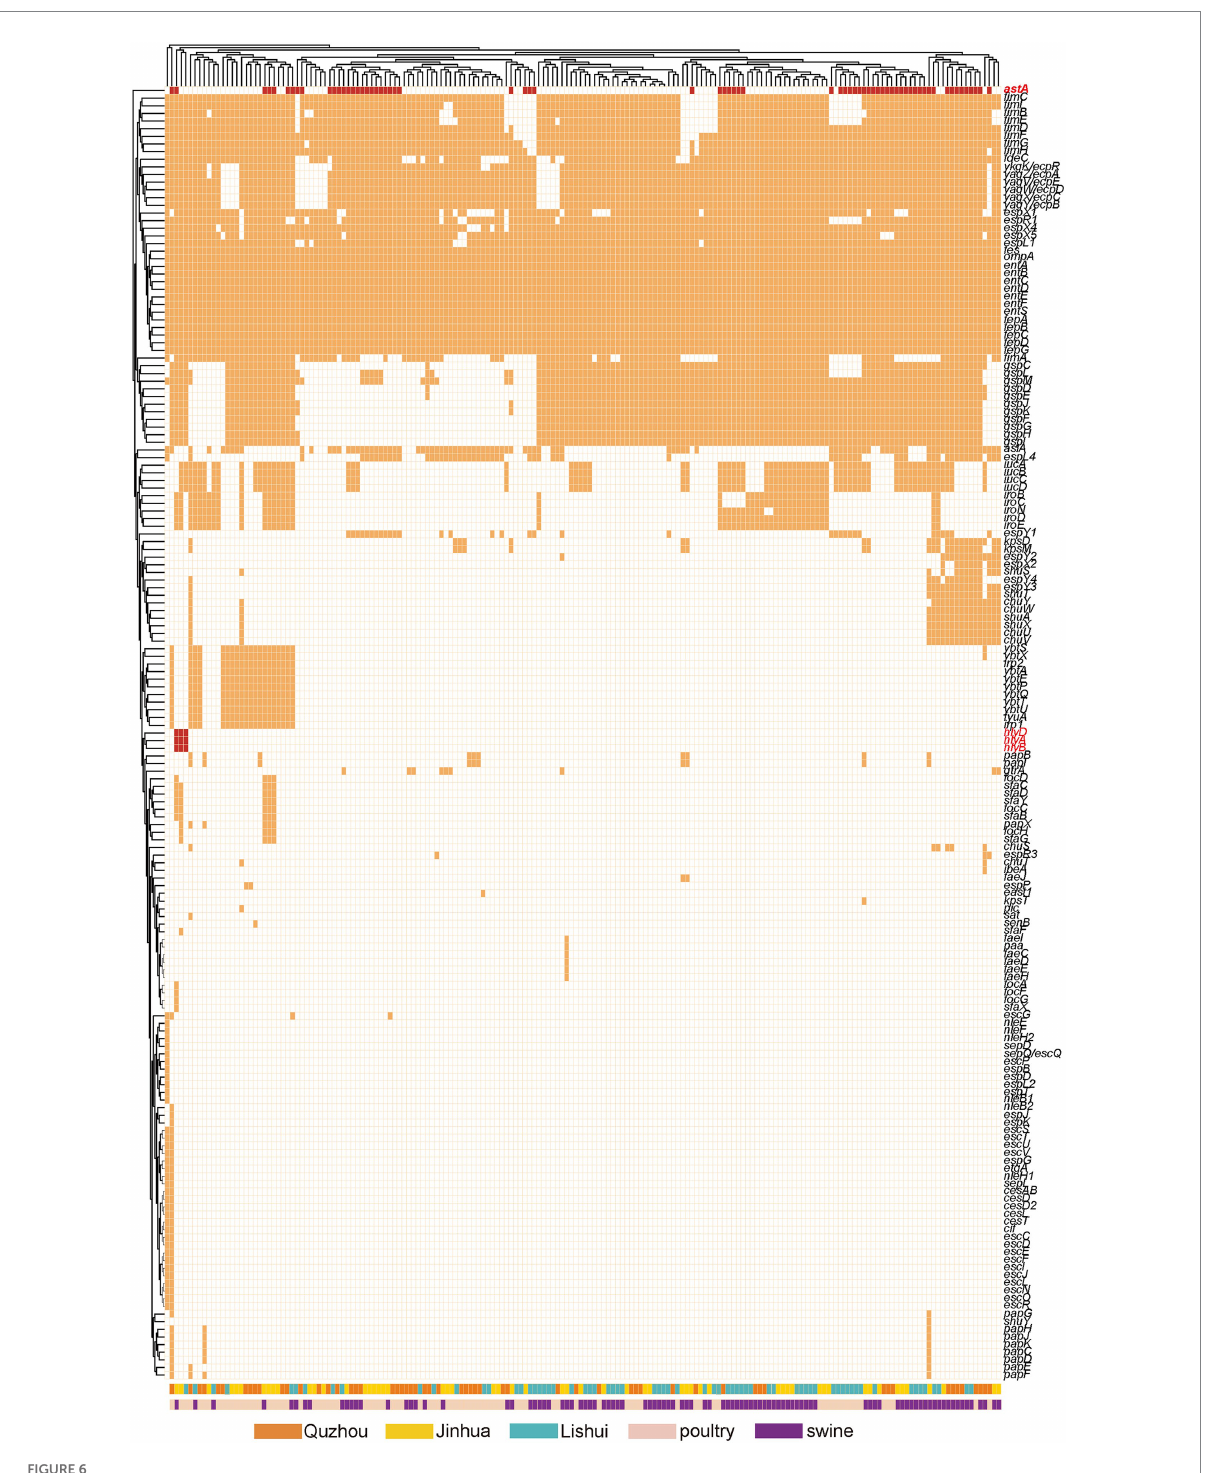
FIGURE 6 Dendrogram of the hierarchical clustering heat map of isolates and virulence genes. The figure shows the predicted virulence genes factor profile of the studied isolates. Y-axis is the isolate number and x-axis is the selected virulence genes identified. The red color in the small cells indicates virulence genes associated with toxin production, the orange color indicates genes editing other virulence factors, and the white color indicates no virulence expression. Withered grass color indicates isolates isolated from Quzhou samples, yellow indicates isolates from Jinhua, and blue color indicates isolates from Lishui. Incarnadine pink indicates that the isolates were isolated from pig anal swab samples, and bright green indicates that they were isolated from